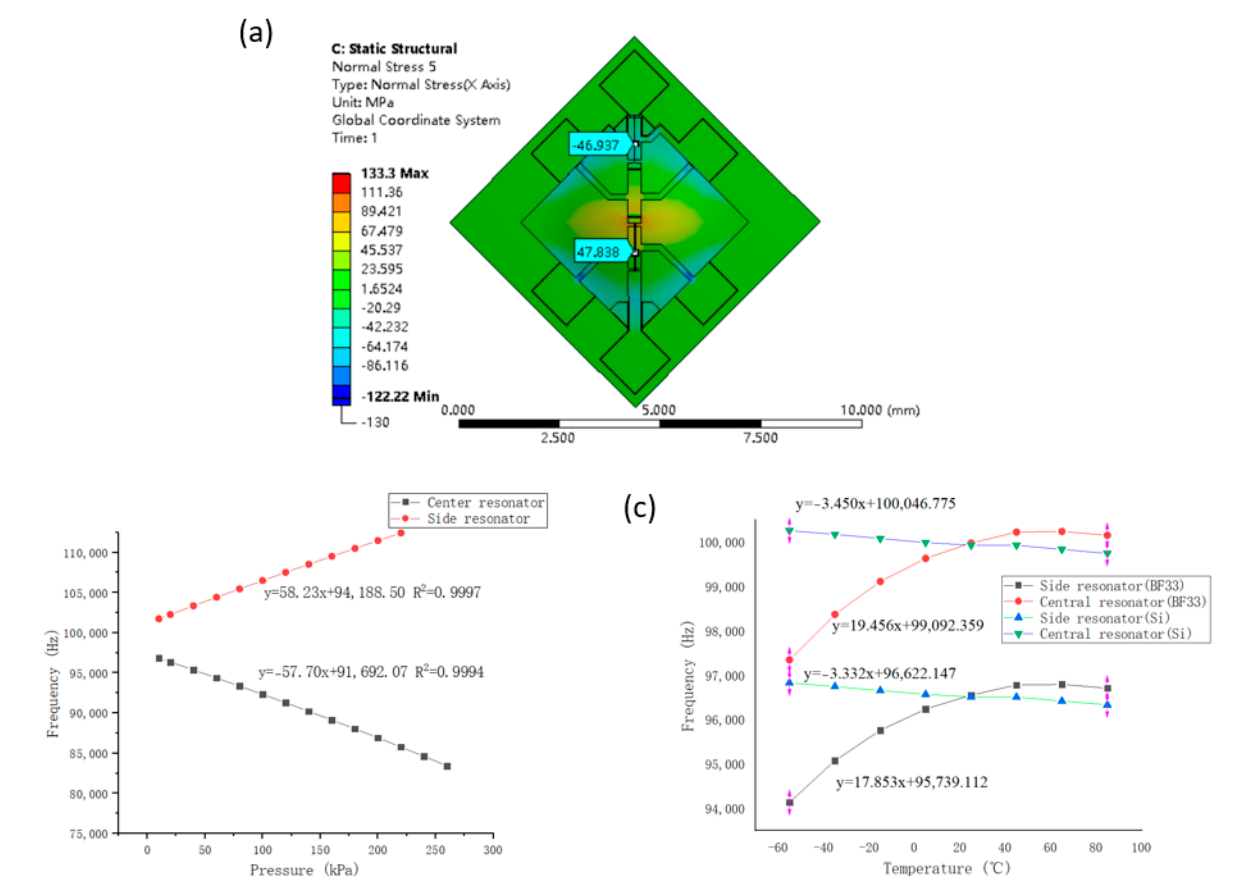
Figure 2. Numerical simulations: ( a ) positive stress distribution of the central and side resonators on the device layer under a pressure of 260 kPa, ( b ) resonant frequencies of the central and side resonators as a function of pressures under measurements, and ( c ) resonant frequencies of the central and side resonators with silicon or glass encapsulation as a function of temperature variations.